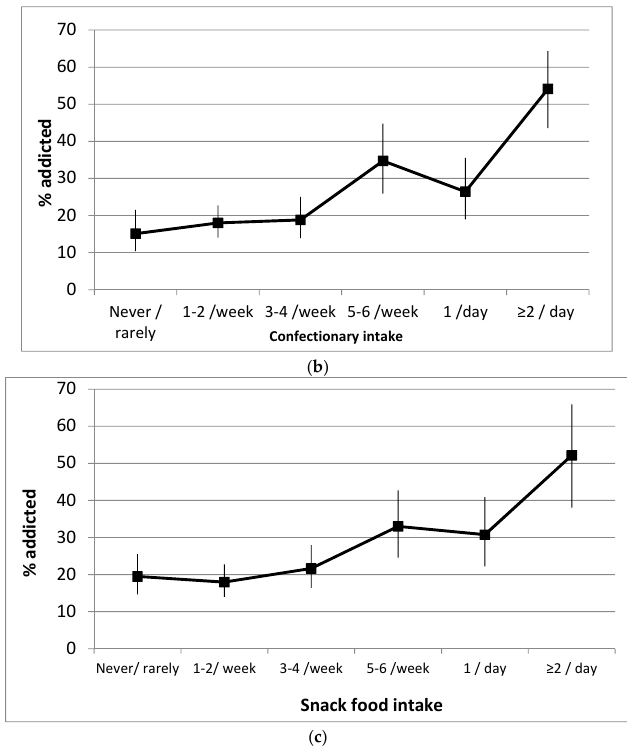
Figure 1. Percentage of food addicted individuals by frequency of core food group ( a ) vegetable intake; ( b ) confectionary intake; ( c ) snack food intake. Data is mean with bars representing the 95% CI.